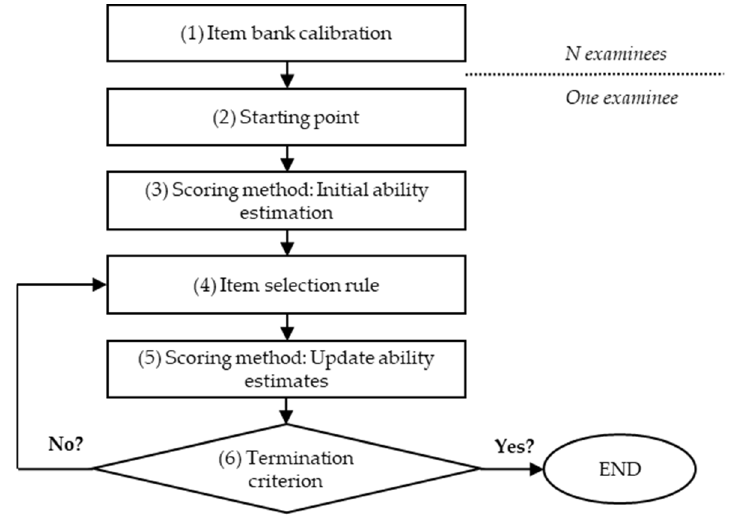
Figure 2. Workflow of a computerized adaptive testing application.